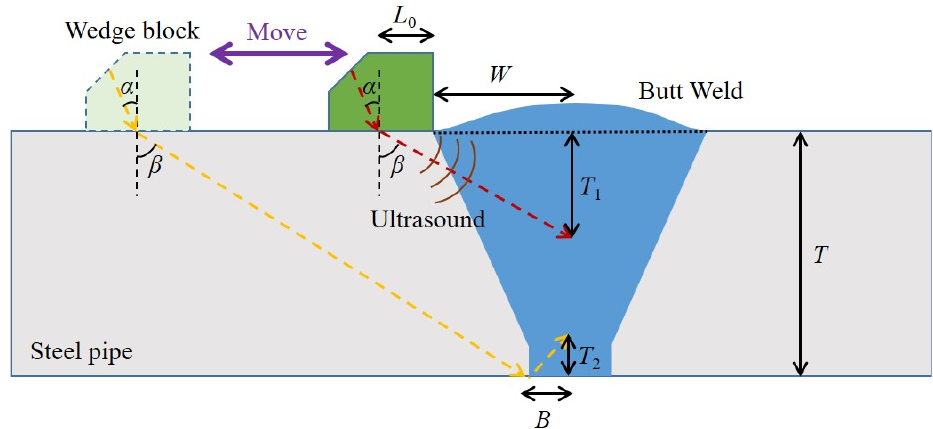
Figure 2. Detection of the butted weld with the primary and secondary ultrasound waves.